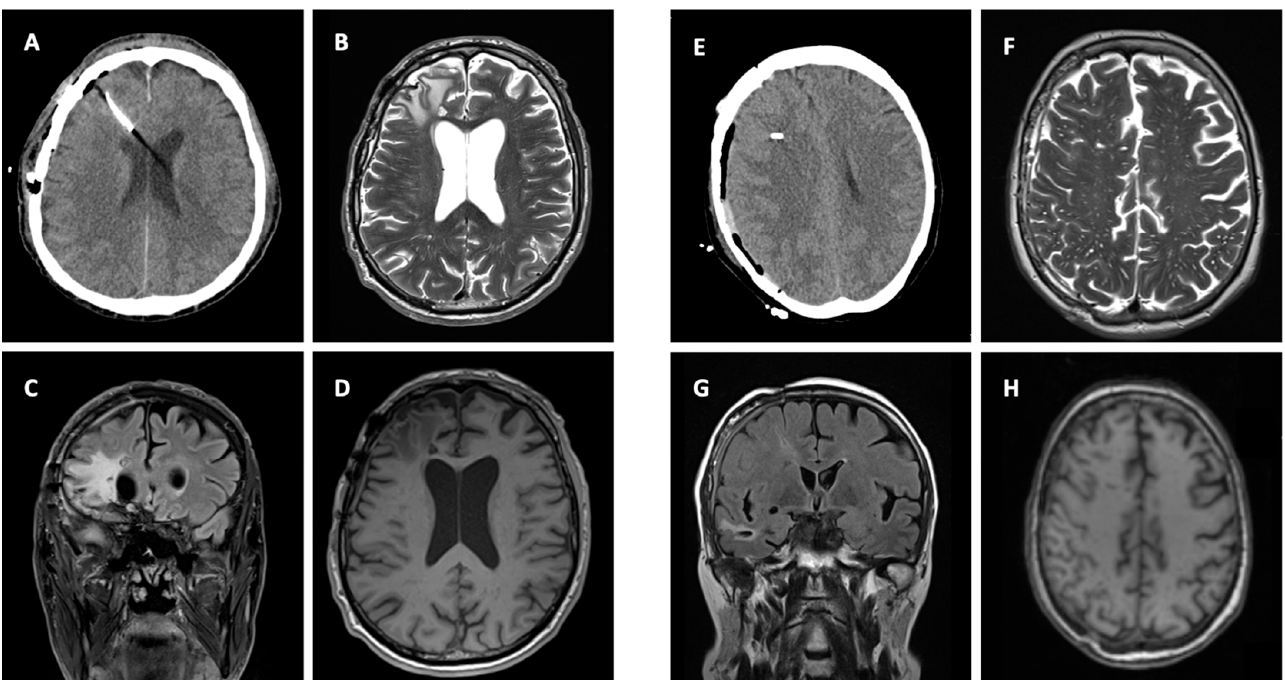
Figure 2. Two exemplary MRI lesions after removal of ICP probe. Panel ( A , E ) show a cerebral CT scan with probes in place. Panel ( B , F ) show axial T2-weighted MRI after removal of the probe. Panel ( C , D , G , H ) show corresponding Flair MRI after probe removal.